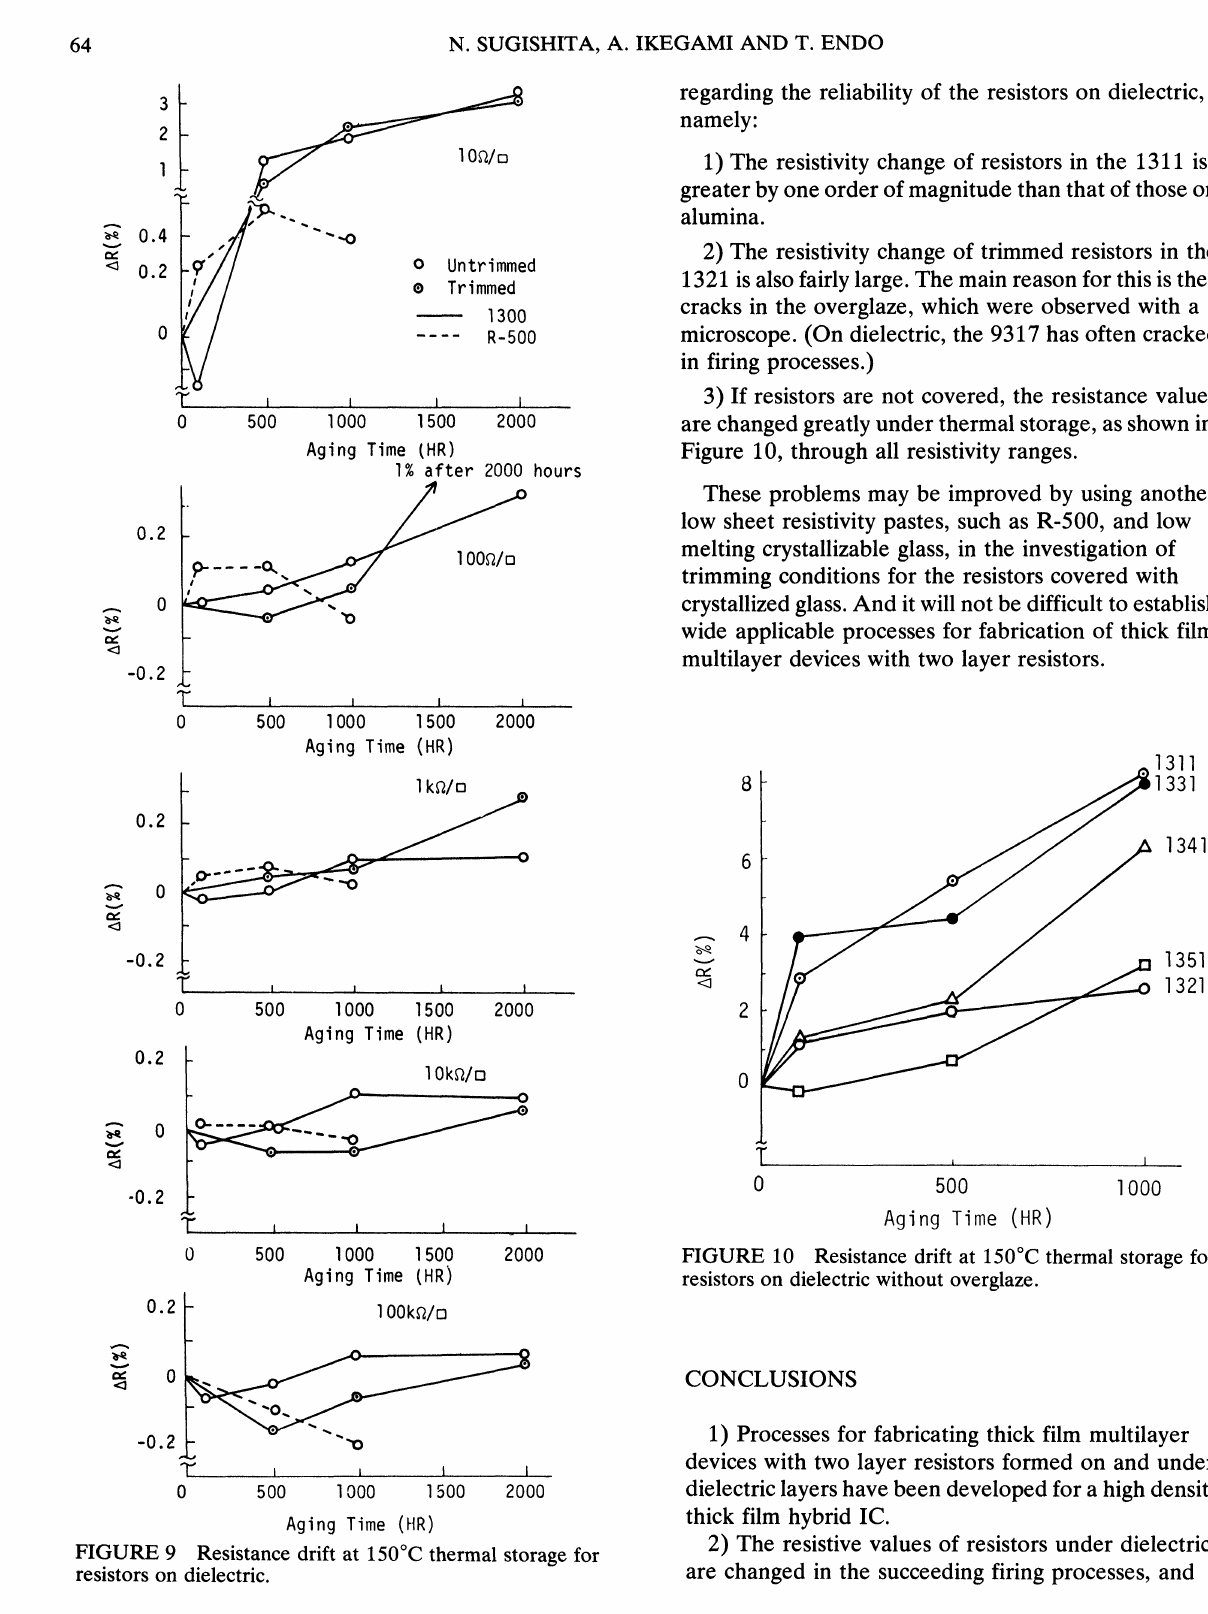
FIGURE 10 Resistance drift at 150C thermal storage for resistors on dielectric without